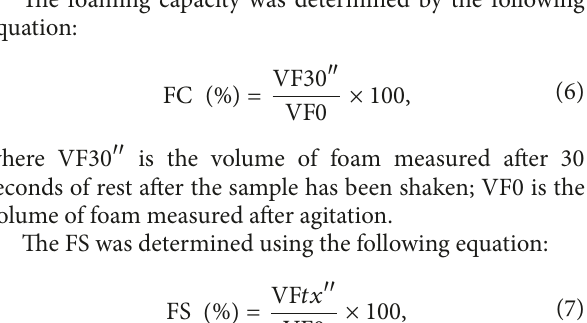
Table 1: Chemical composition of seed flour of varieties of Lupinus angustifolius cultivated in Mexico (% dry basis). Variety Moisture Protein Ash Fat Crude fiber Carbohydrates Haags Blaue 3.59 b 32.33 b Boregine 3.65 b Borlu 4.38 a Probor 3.84 b Sonate 3.79 b Boruta 3.68 b Different letters in rows indicate significant differences ( 𝑃 < 0.05